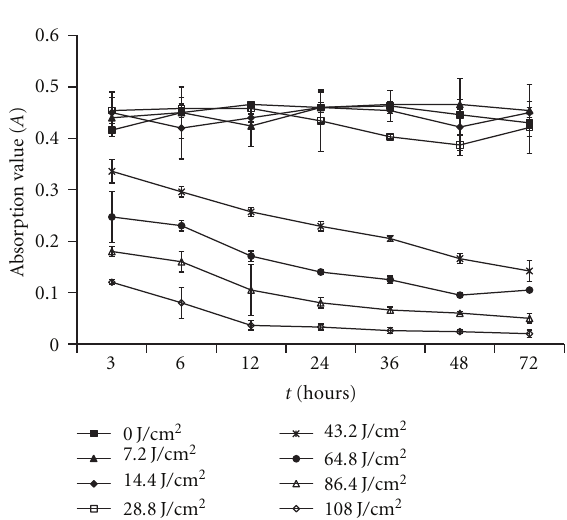
Figure 1: Viability of normal human fibroblasts after UVA irradiation. Normal human fibroblasts were irradiated with UVA at the indicated dosage (J/cm 2 ), and then cell viability was determined using MTT method at the indicated time (h). No change in cell viability under 7.2, 14.4, and 28.8 J/cm 2 UVA irradiation was seen in comparison with the sham-irradiated cells ( P > 0 . 05; One- way ANOVA) and no di ff erence among the three dosages was seen ( P > 0 . 05, One-way ANOVA). Decrease in cell viability was observed with the UVA dose over 43.2 J/cm 2 . Twenty-four hours after 86.4 J/cm 2 UVA treatment, cell viability only reached 19.7%, in multiple comparisons with the LSD method. Significant di ff erence among 43.2, 64.8, 86.4, and 108J/cm 2 UVA irradiation was